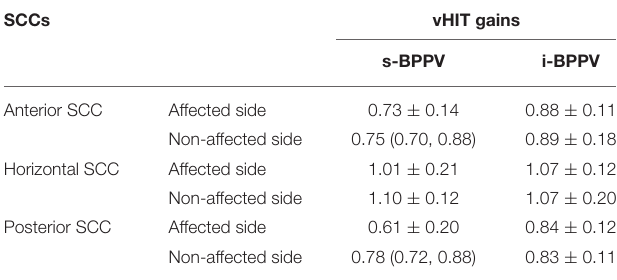
TABLE 2 | vHIT gains of the anterior, horizontal, and posterior semicircular canals in patients with s-BPPV and i-BPPV.